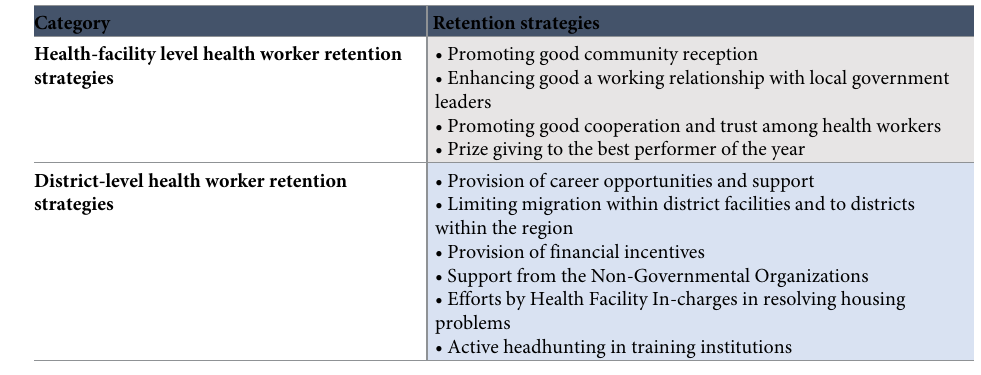
Table 3. Summary of retention strategies by